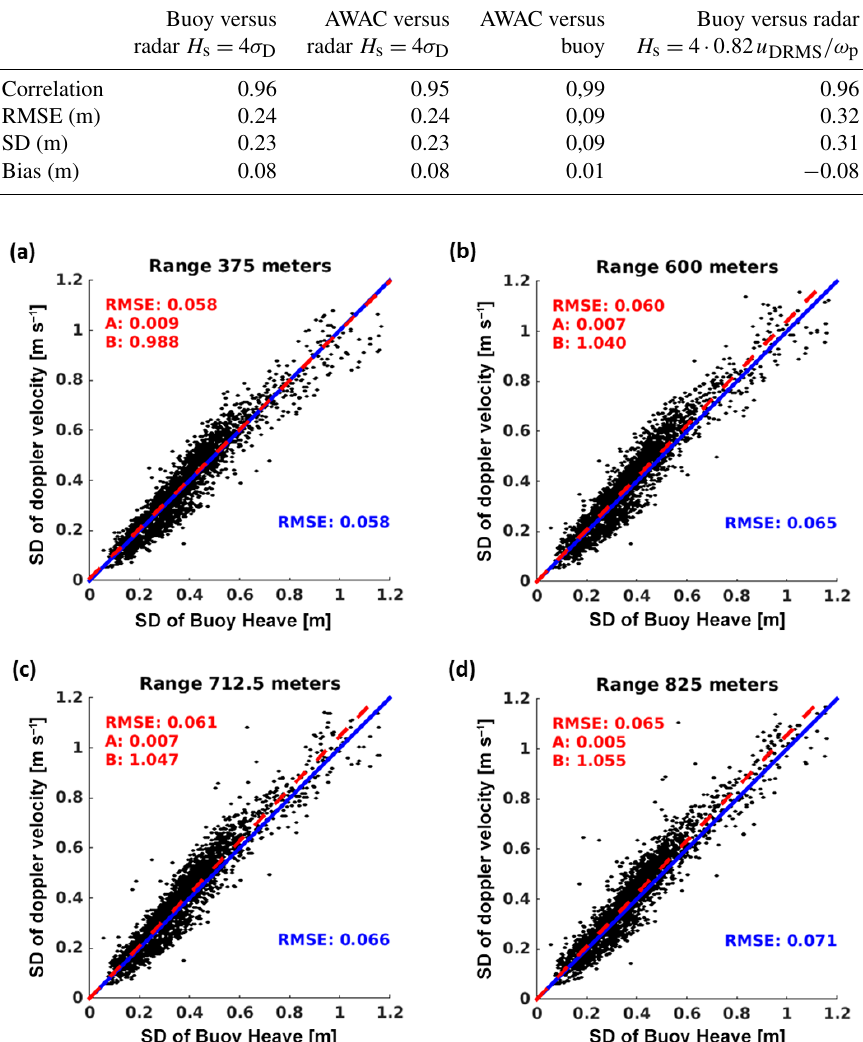
Figure 6. Scatter plot of standard deviation (SD) of buoy heave versus SD radar Doppler velocity. The SD of radar Doppler velocity was retrieved for range distances of (a) 375m, (b) 600m, (c) 712.5m and (d) 825m. In the upper left of each plot the linear regression fit parameters A and B are given with f (x) = A + Bx